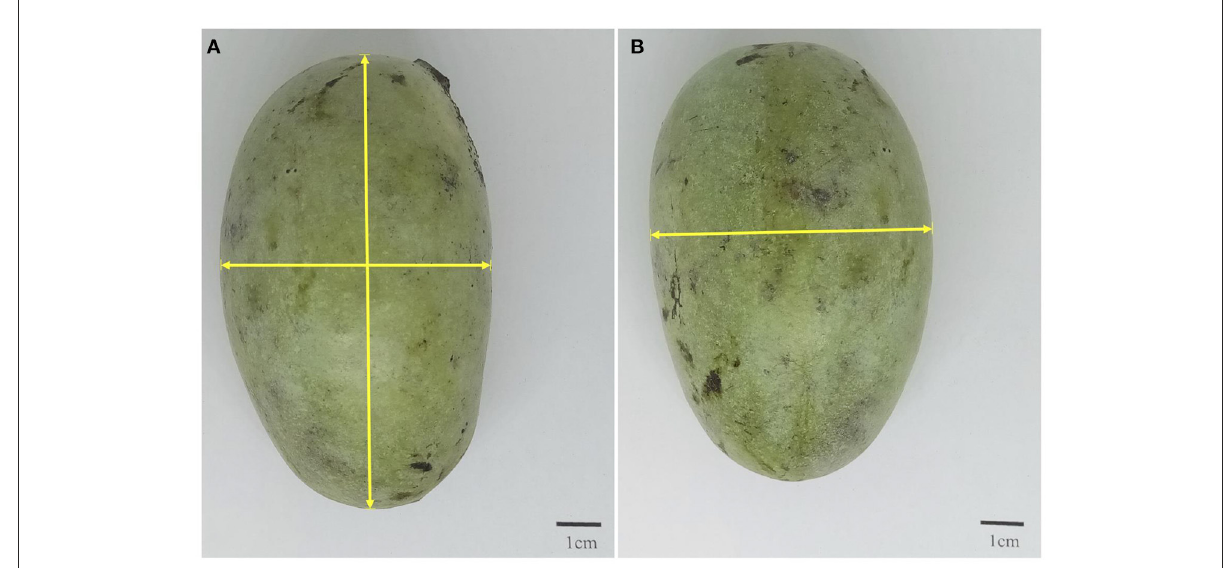
FIGURE1 Pictorial demonstration of how (A) fruit length and width and (B) thickness were